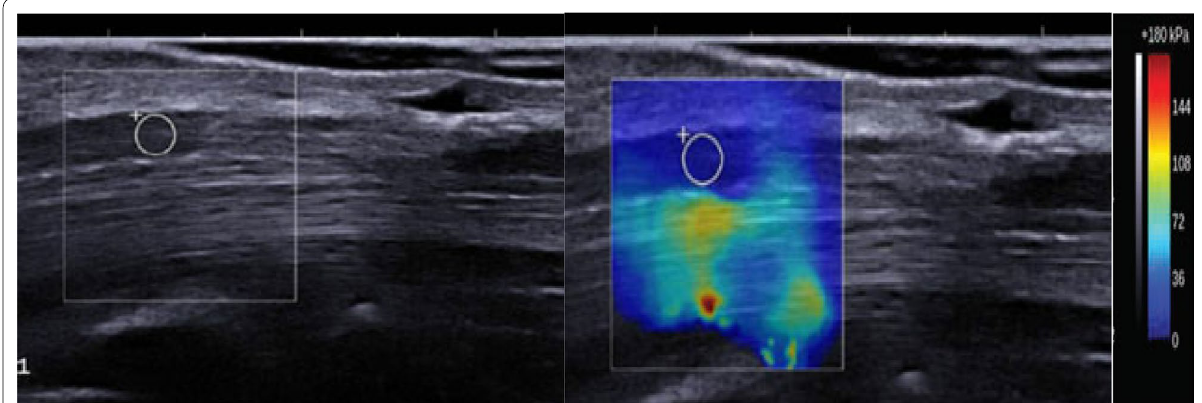
Fig. 4 A 37-year-old female patient with mild grade of carpal tunnel syndrome by electrophysiological diagnostic studies. ( Left ) High-resolution conventional B-mode ultrasound showed mildly thickened median nerve with increased CSA (10.4 mm 2 ) and wrist/forearm ratio (1.9). ( Right ) Shear-wave elastography of the median nerve displayed mildly increased mean median nerve stiffness value